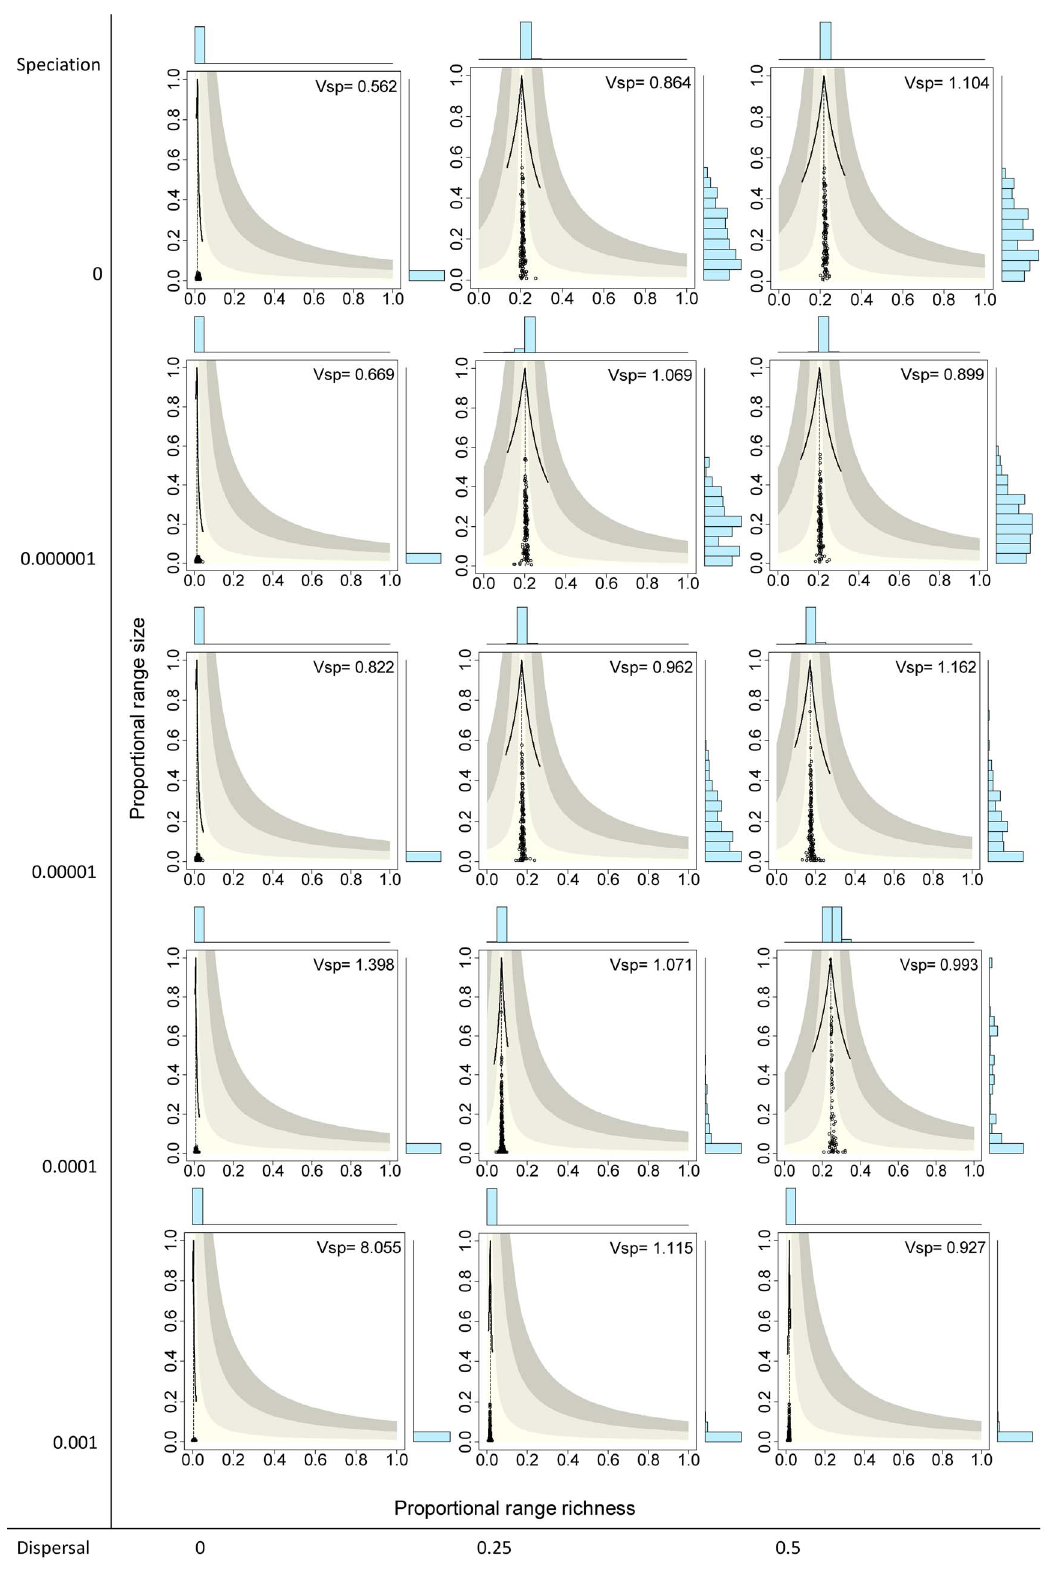
Figure 3. Range-diversity plots by species for different combinations of the speciation and dispersal parameters in neutral models. Information as in Figure 2A.